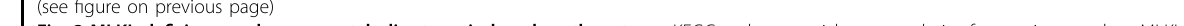
Fig. 3 MLKL de fi ciency enhances metabolic stress-induced parthanatos. a KEGG pathway enrichment analysis of transcriptome data. MLKL-KO Hepa 1 – 6-luc (sgMLKL) or control (sgNC) cells were orthotopically implanted in the liver of C57BL/6 mice. Tumors collected at the endpoint of the study were subjected to RNA-seq analysis. b Cell death upon metabolic stress in HCC cells. MLKL-KO and control Hepa 1 – 6 cells were challenged with indicated nutrient deprivation or lipid stress (0.2 mM PA) for 24 h and cell death was measured by LDH leakage. c Cell death induced by PA. MLKL-KO and control Hepa 1 – 6 cells were treated with BSA or 0.2 mM PA for 24 h. Cell death was measured by SYTOX Green assay. d Dendritic cell activation. MLKL-KO Hepa 1 – 6 and control cells were treated with or without PA (0.2 mM, 24 h) and supernatant was collected as conditioned medium. BMDCs isolated from C57BL/6 mice were treated with conditioned medium for 24 h. Left, schematic diagram of the assay. Right, CD80 expression was analyzed using fl ow cytometry analysis. e PARP inhibition reverses cell death in MLKL-de fi cient cells. MLKL-KO and control Hepa 1 – 6 cells were treated with 0.2 mM PA and/or Olaparib at indicated concentrations for 24 h. f Immunoblotting analysis of PAR polymer accumulation. MLKL-KO and control Hepa 1 – 6 cells were treated with BSA or 0.2 mM PA for 20 h and then analyzed by immunoblotting. g AIF staining. Cells were treated as in f and AIF was stained using immuno fl uorescence. Left, representative images, scale bar, 10 μ m. Arrows indicate AIF staining in the nucleus. Right, quanti fi cation of nuclear AIF positive cells. h Orthotopic tumor growth of MLKL-KO and control murine HCC cells. Cells were orthotopically implanted in the liver of C57BL/6 mice ( n = 6). Mice were treated with or without Olaparib (50 mg/kg) daily. Tumor growth was monitored by whole-animal imaging. Shown were representative luminescent images. i Endpoint tumor weight as in h . Data are represented as means ± SEM. Two-tailed Student ’ s t -test was used for statistical analysis. ns, not signi fi cant; * P < 0.05, ** P < 0.01, *** P <